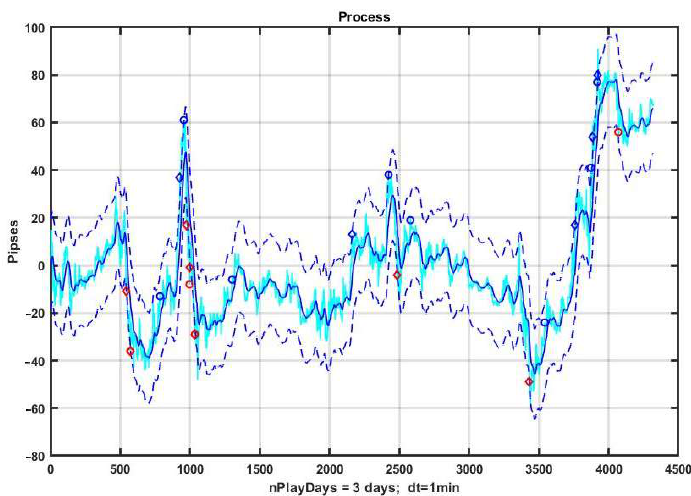
Figure 8. Example CSF implementation with three optimized parameters.